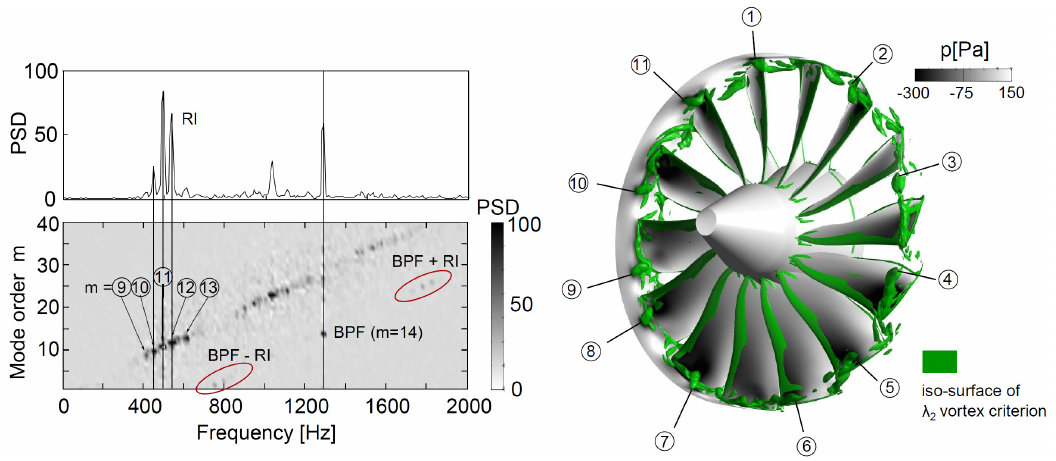
Figure 9. Mode analysis and visualisation of flow disturbances